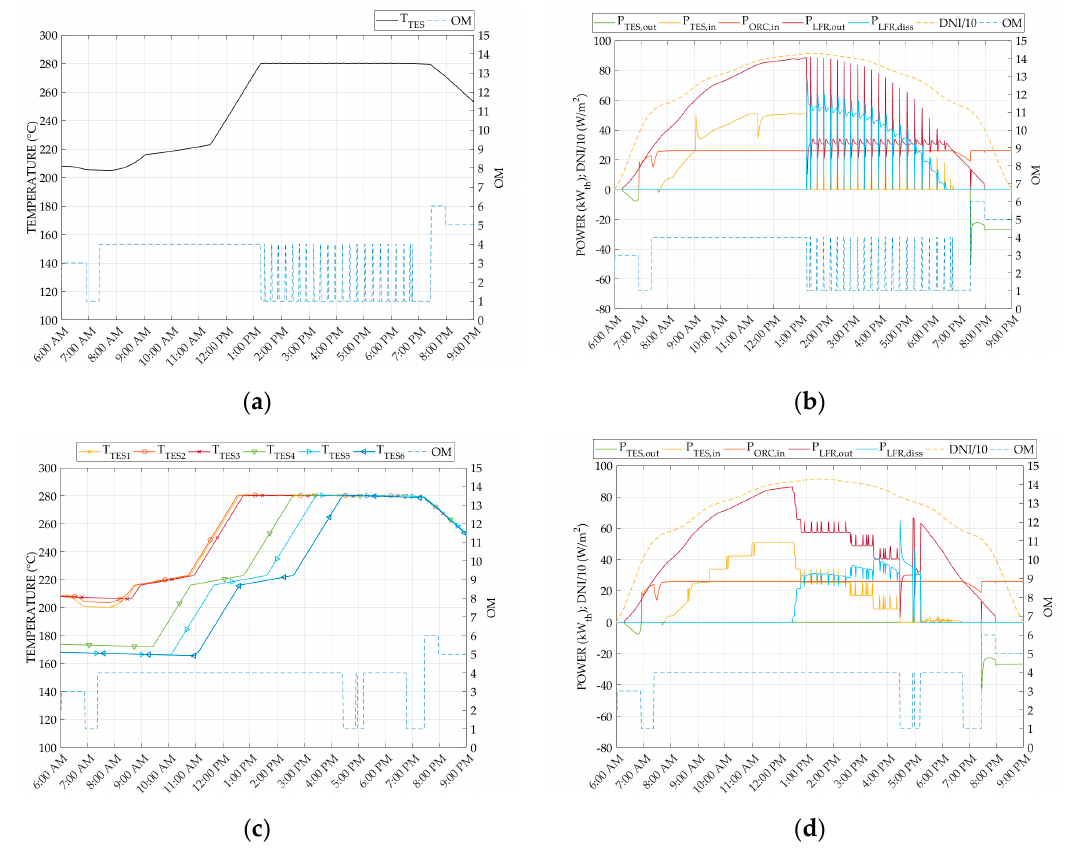
Figure 7. Daily temperatures ( a ) and power trends ( b ) of the LHTES compared with the daily temperature ( c ) and power trends ( d ) of the sub-LHTES for a typical summer season day (11 June). The graphs represent also the operating mode (OM) of the plant, as specified in Table 1.